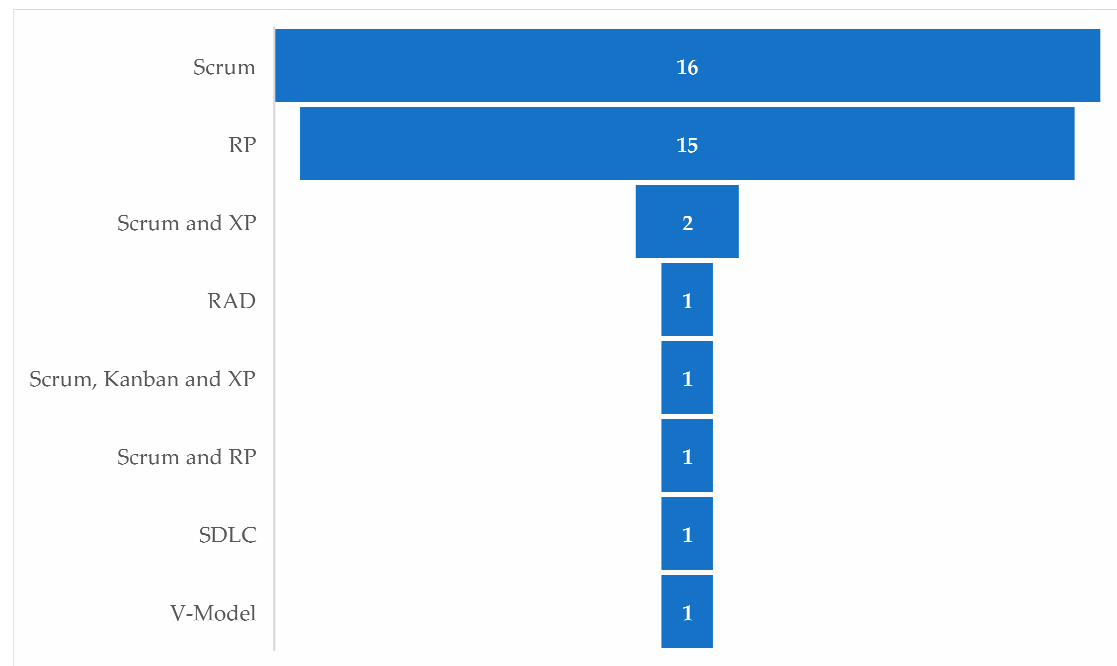
Figure 4. Number of IoTSs developed with methodologies designed for the development of ISs.